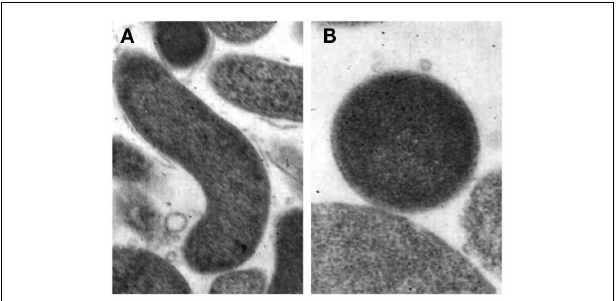
FIGURE 2 | Morphological appearances of Helicobacter pylori . (A) Rod-shaped (B) Coccoid form. Original magnification (cid:2) 20,000 (58).